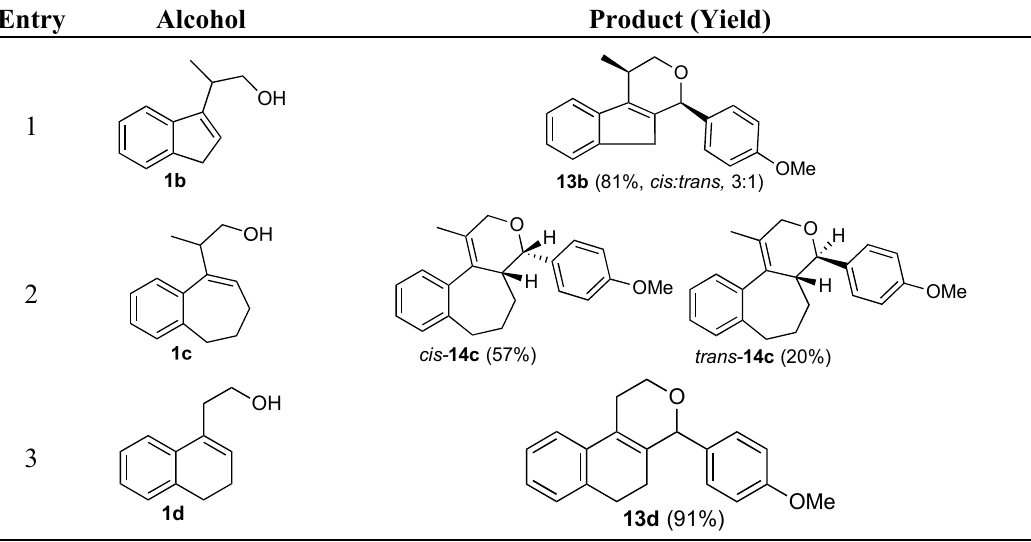
Table 4. Prins cyclization of homoallylic alcohols bearing endocyclic double bonds with 2b